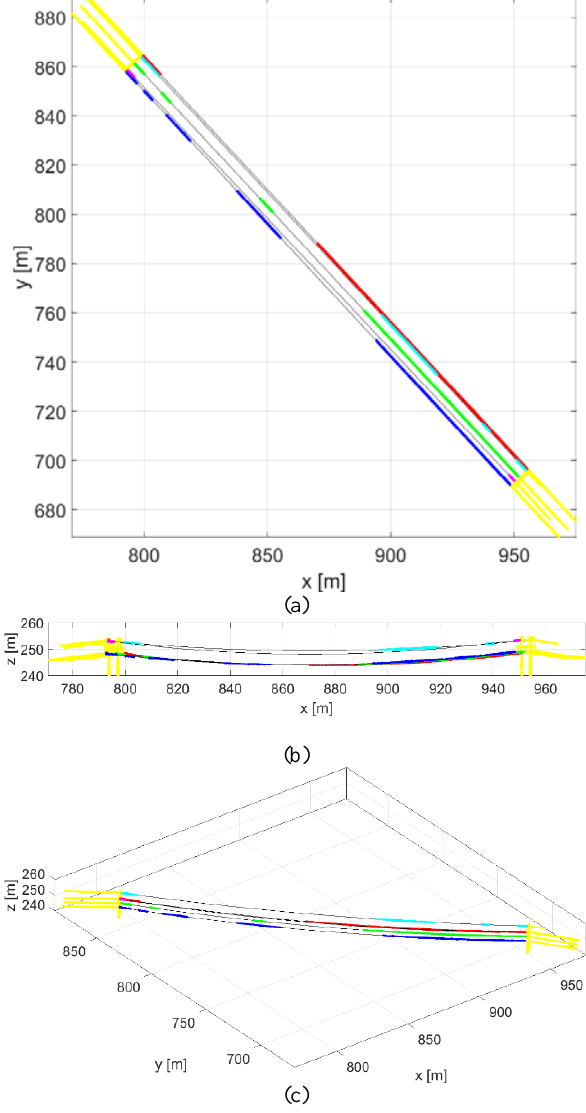
Figure 9. Wires reconstructed from estimated parameters: (a) top view, (b) side view, (c) isometric